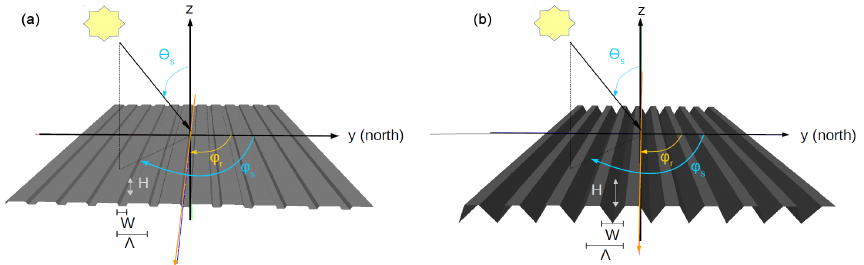
Figure 1. Illustration of the set-ups for (a) A η 27% and B η 27% experiments and (b) C rough 90 ◦ and D rough 90 ◦ experiments (Table 1 for acronyms). The grey surfaces are modelled meshes with parallel shapes (rectangular or triangular), similar to the artificial roughness surfaces created in the field. The two sites are areas of 2.5m × 2 . 5m. H is the height, W the width and (cid:51) the period of roughness features. ϕ r is the roughness orientation, ϕ s the solar azimuth angle and θ s the solar zenith angle. Azimuth angles are clockwise from north ( y axis).